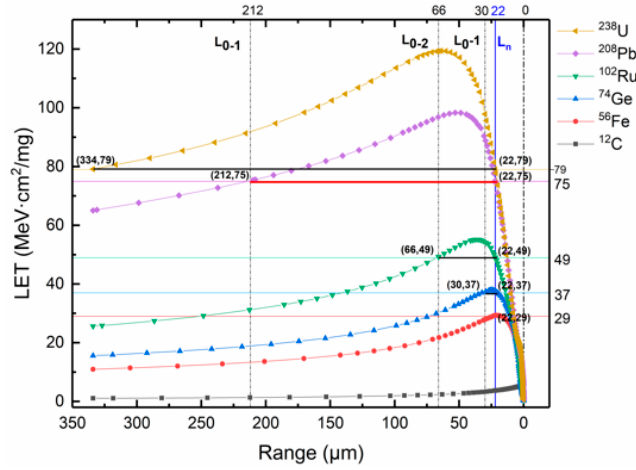
Figure 8. The heavy-ion LETs as a function of penetration range in silicon when the heavy-ion range is calibrated using the 56 Fe ion Bragg peak.